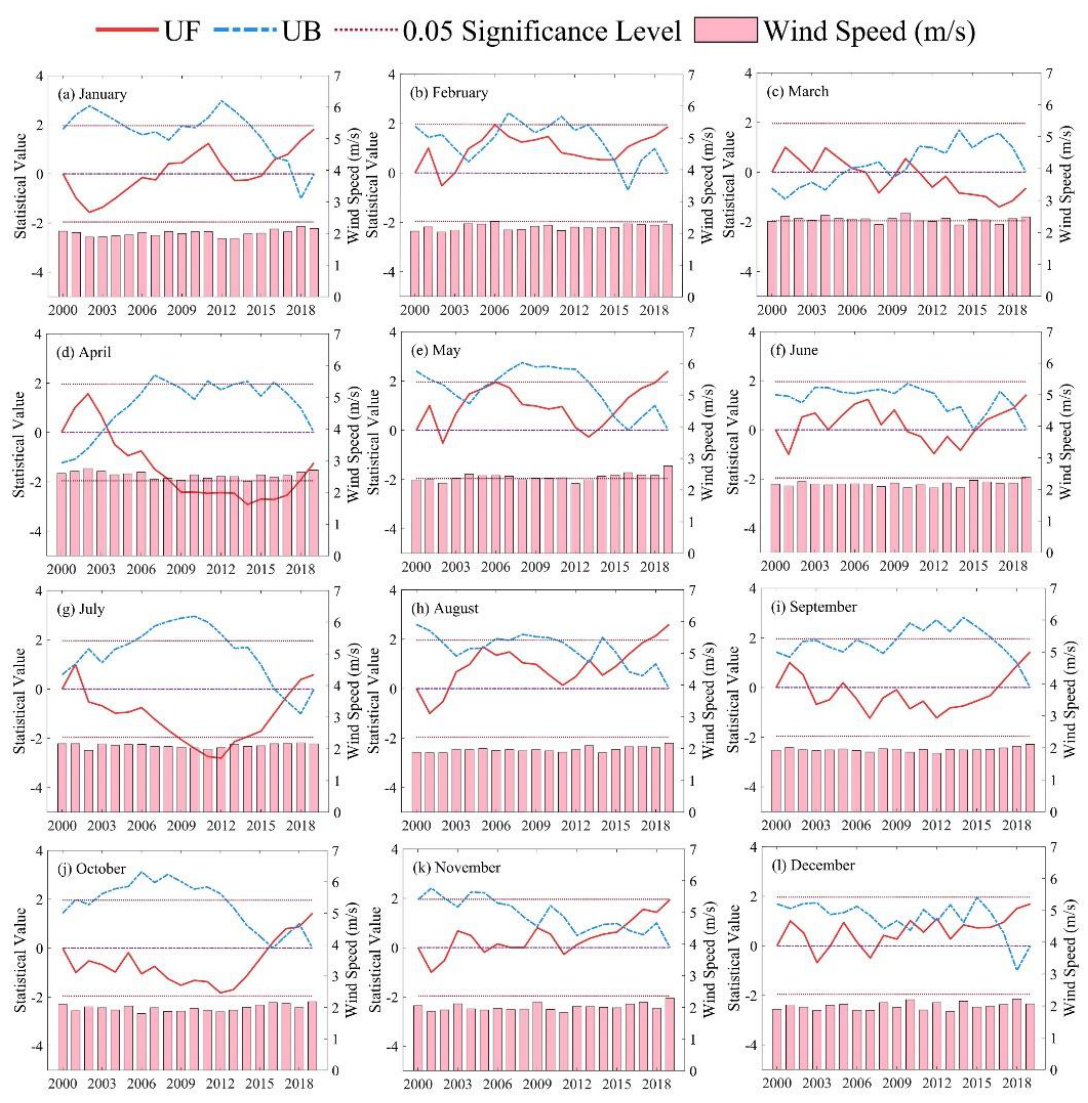
Figure 4. Mean value and statistical curve of the M-K trend and abrupt test for 12 months: Wind speeds in ( a ) January; ( b ) February; ( c ) March; ( d ) April; ( e ) May; ( f ) June; ( g ) July; ( h ) August; ( i ) September; ( j ) October; ( k ) November; ( l ) December from 2000 to 2019 in China.